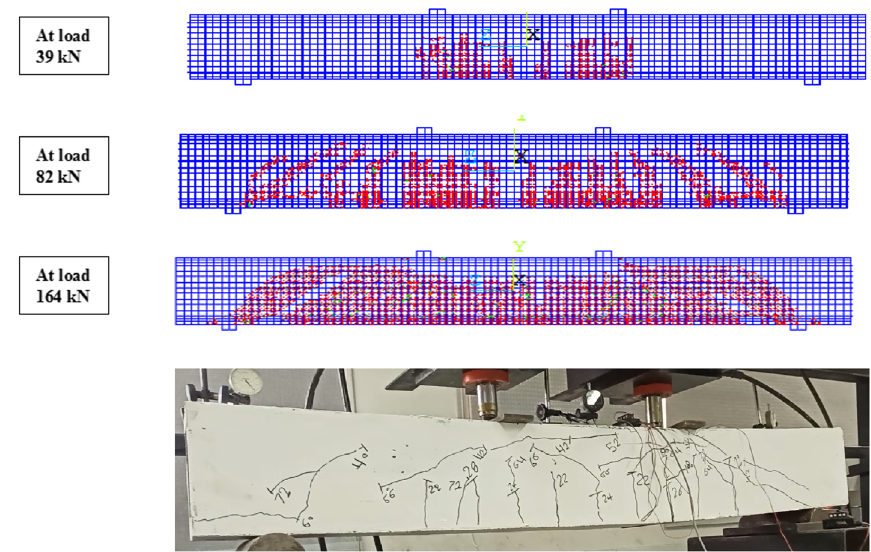
Fig. 23 FCH1 specimen cracks pattern